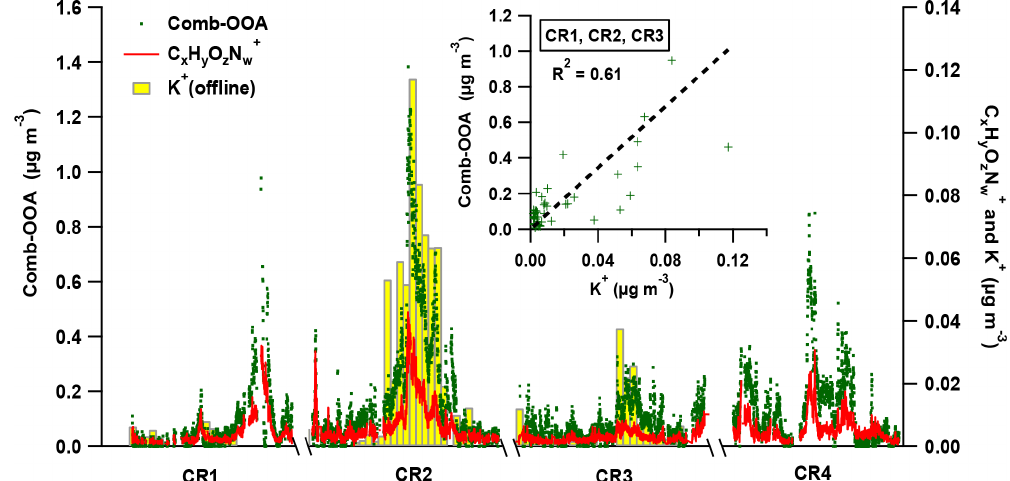
Figure 8. The variation of Comb-OOA (green dot), C x H y O z N + w fragments (red line) and potassium (K + , the yellow bar with grey box) during Polarstern cruises. Note that the 24h average mass concentration of K + is obtained from offline measurements only performed during the first three cruises. The scattering plot in the sub-window provides the correlation between 24h average mass concentration of Comb-OOA from AMS and potassium from offline